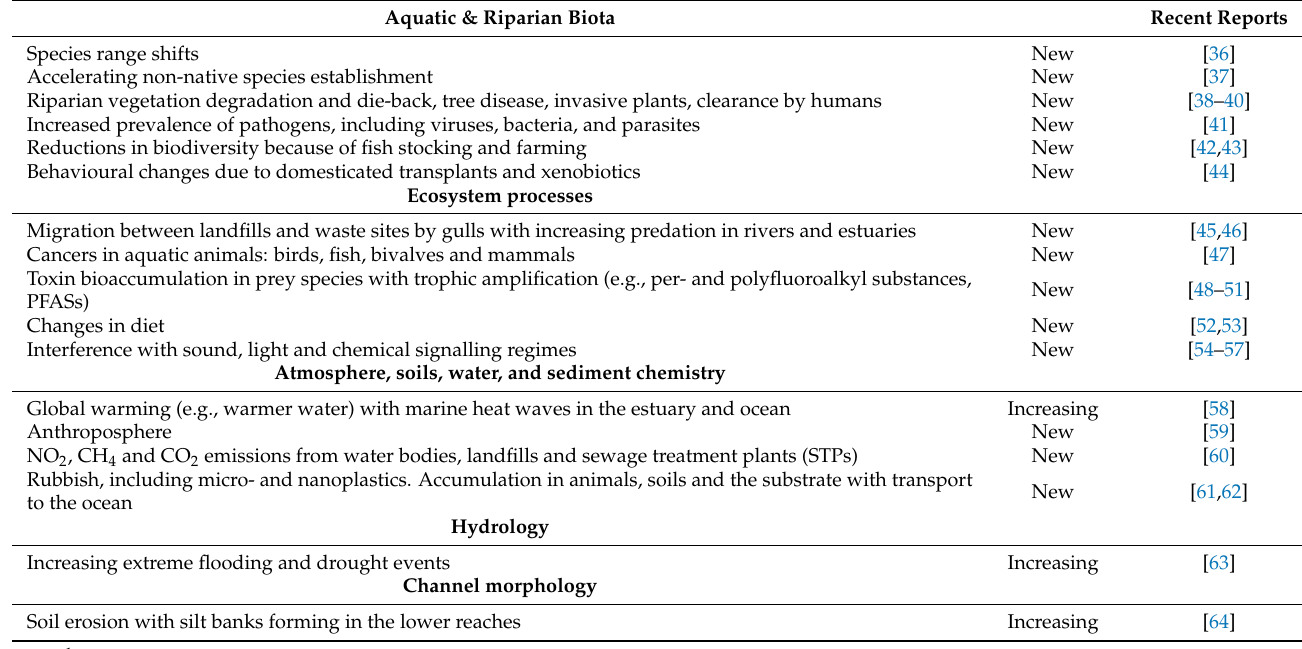
Table 2. Additional and increasing symptoms of an updated urban river syndrome 1